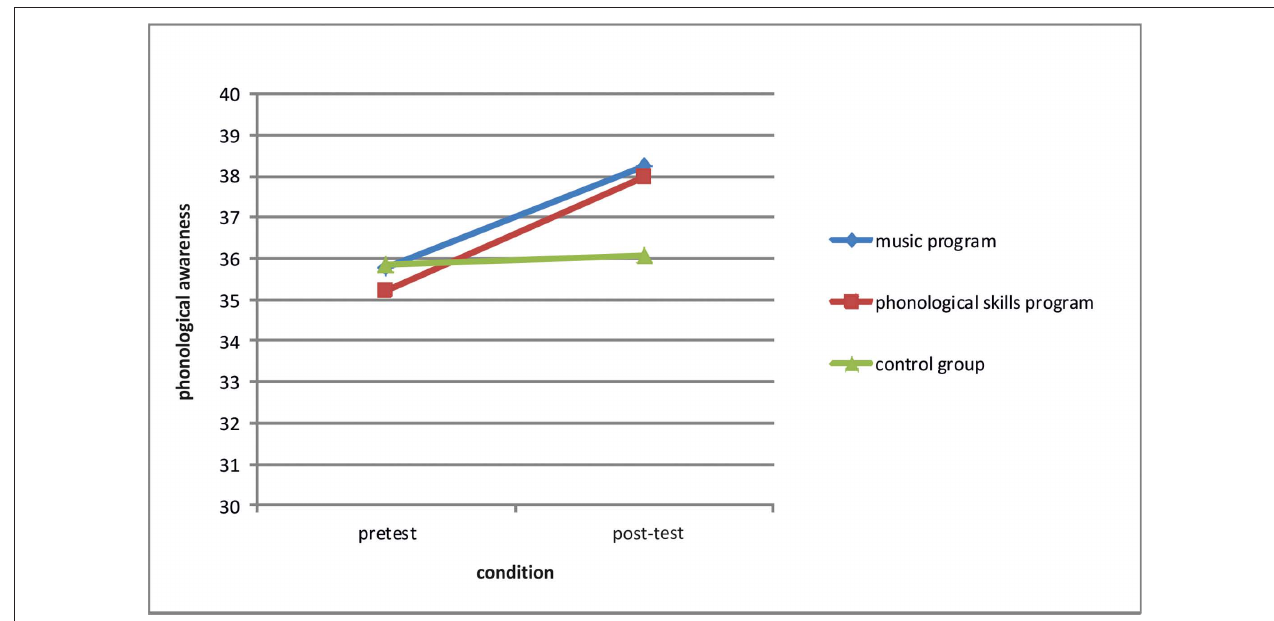
Figure 1 | Mean phonological awareness score at pre- and post-test in the music group, the phonological skills group, and the control